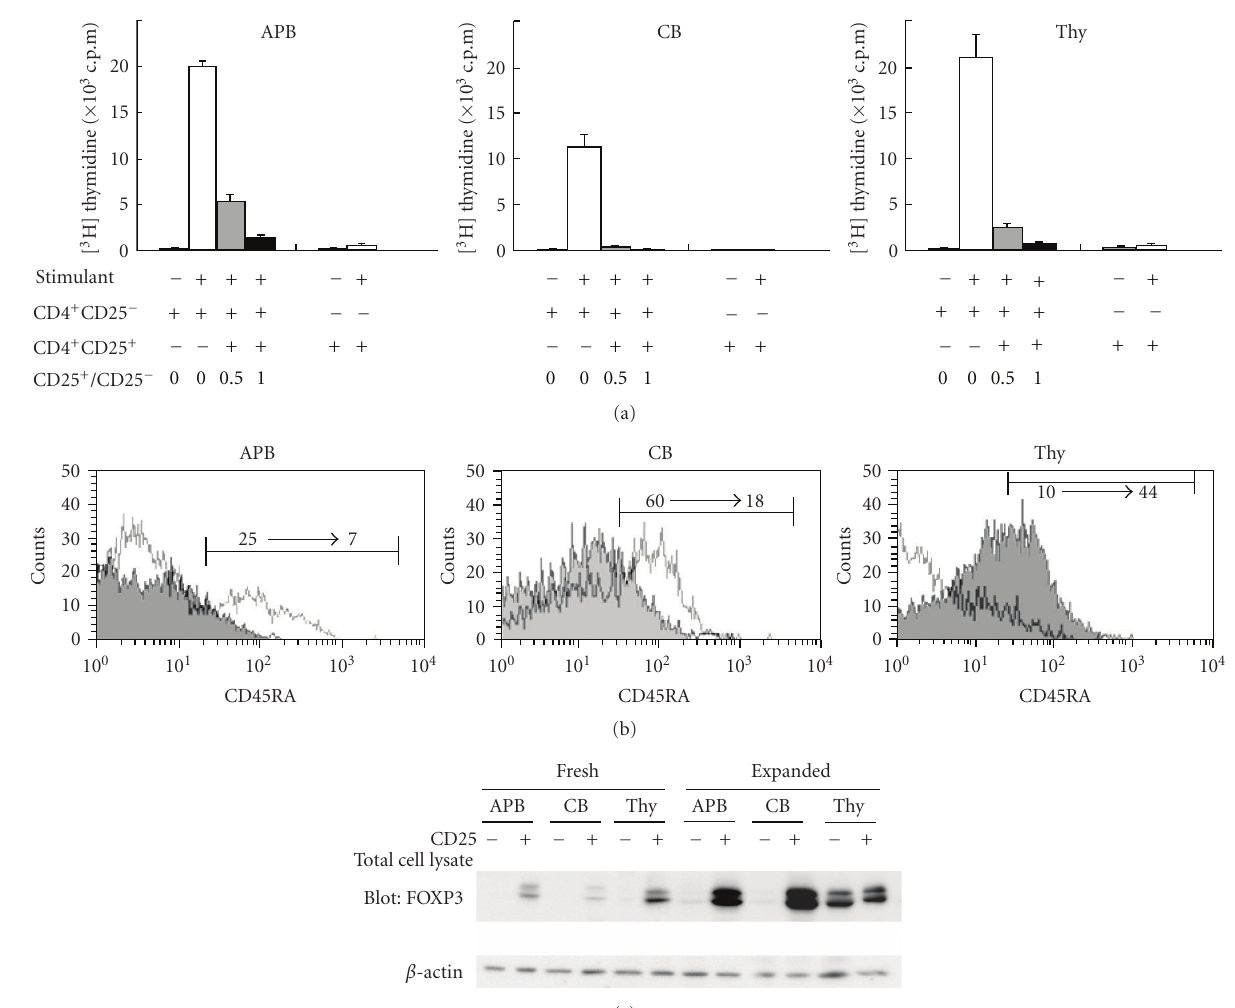
Figure 6: Restoration of suppressive activity in expanded CB CD25 + CD4 + T cells. (a) Freshly isolated CD4 + CD25 + cells were used as Treg in Figure 2(b), and expanded as described in Section 2. Freshly isolated CD25 − CD4 + T cells were used as responder cells in both primary and secondary assays without expansion. Cell proliferation was assessed by 3 H-thymidine uptake on day 4. Data are obtained by experiments with samples of 3 di ff erent donors. (b) Freshly isolated CD4 + CD25 + cells or expanded CD4 + CD25 + cells were stained with anti-CD3, CD25, and CD45RA, and analyzed using FACSCalibur. The cells were gated for CD3 + CD25 + cells and the expression of CD45RA was compared between freshly isolated CD4 + CD25 + cells (open histogram) and expanded CD4 + CD25 + cells (closed histogram). Data are representative of 3 di ff erent donors. (c) Expression of FOXP3 protein was compared between freshly isolated cells and expanded cells by Western blot. Data are representative of 3 di ff erent